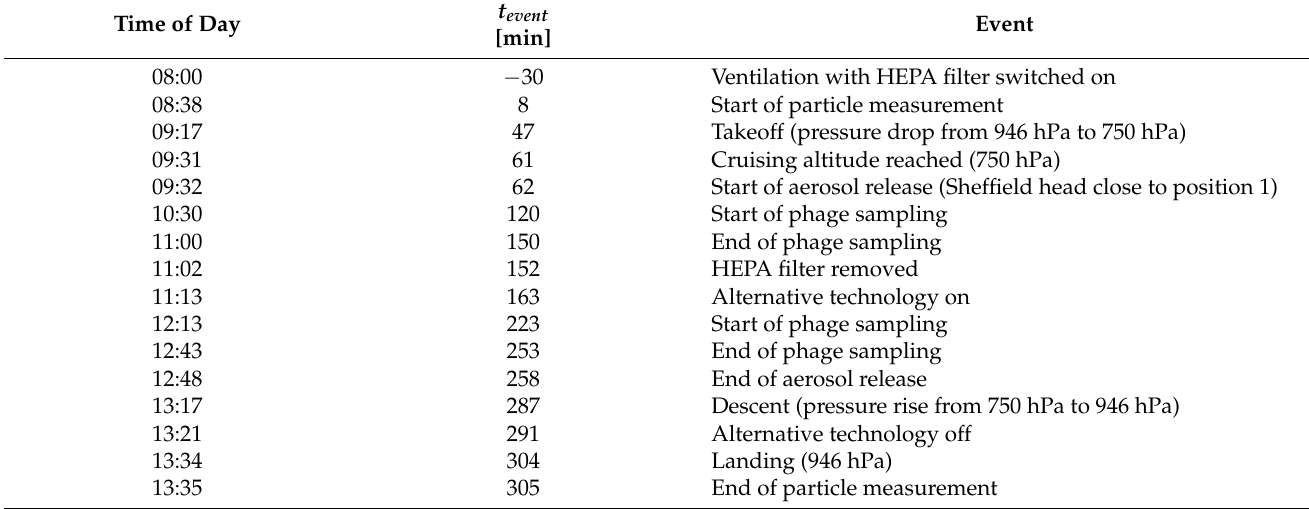
Table 2. Documented events during the investigation in the aircraft